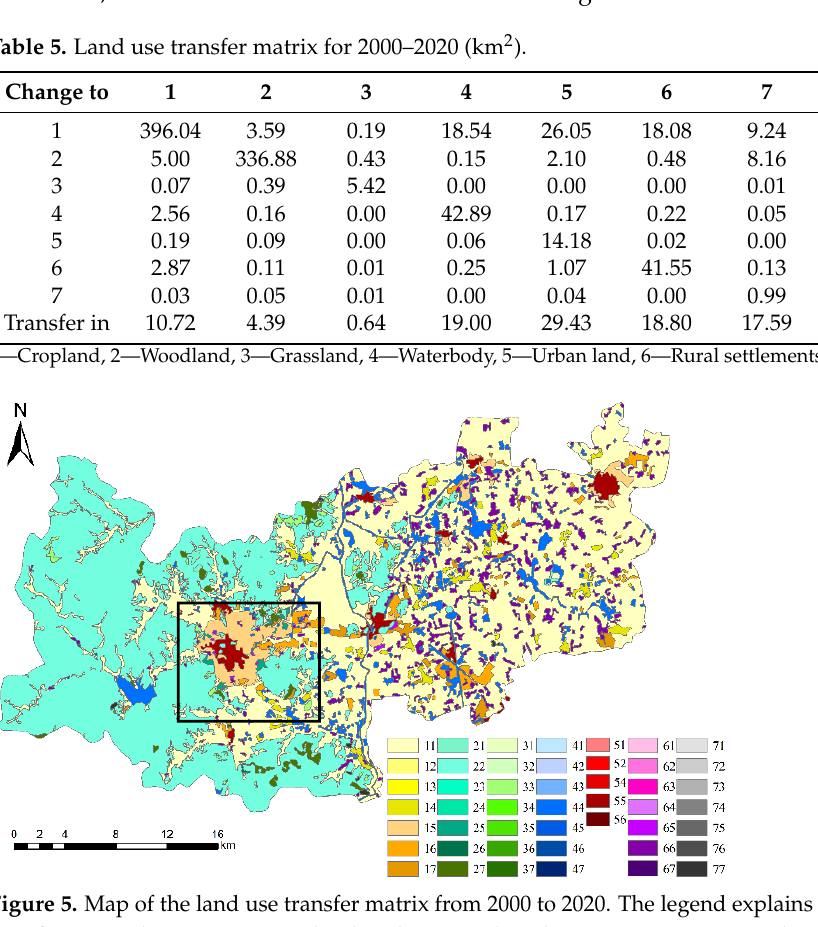
Table 5. Land use transfer matrix for 2000–2020 (km 2 ).